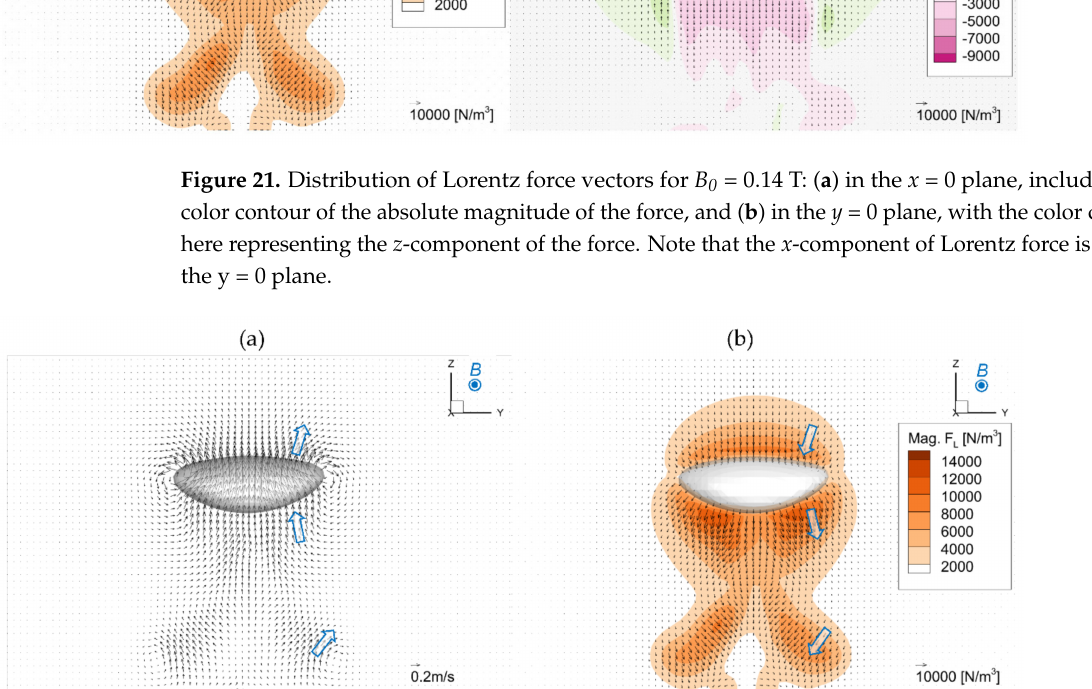
Figure 22. Comparison of ( a ) flow velocity vector distribution and ( b ) Lorentz force distribution for B 0 = 0.14 T in the x = 0 plane. Lorentz force vectors point in the opposite direction to the flow velocity vectors. The bold arrows represent the main feature of the flow velocity ( a ) or the force ( b ).